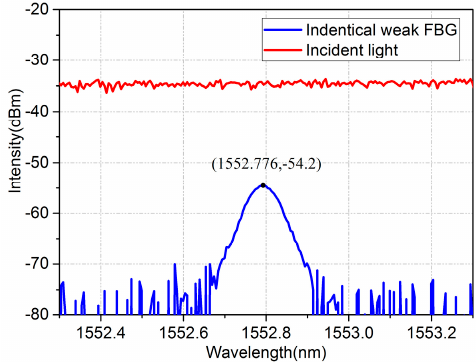
Figure 3. The spectrum of the weak FBG.